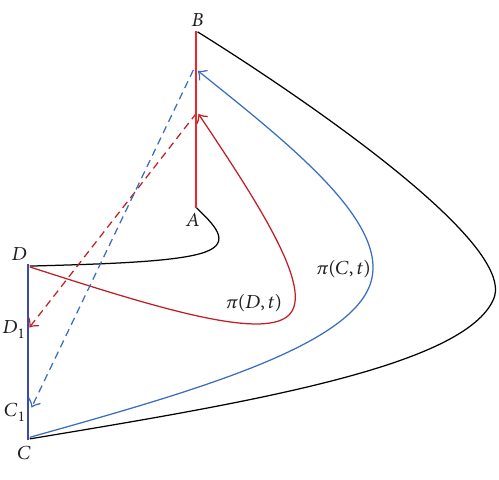
F 2: Illustration of �endixson